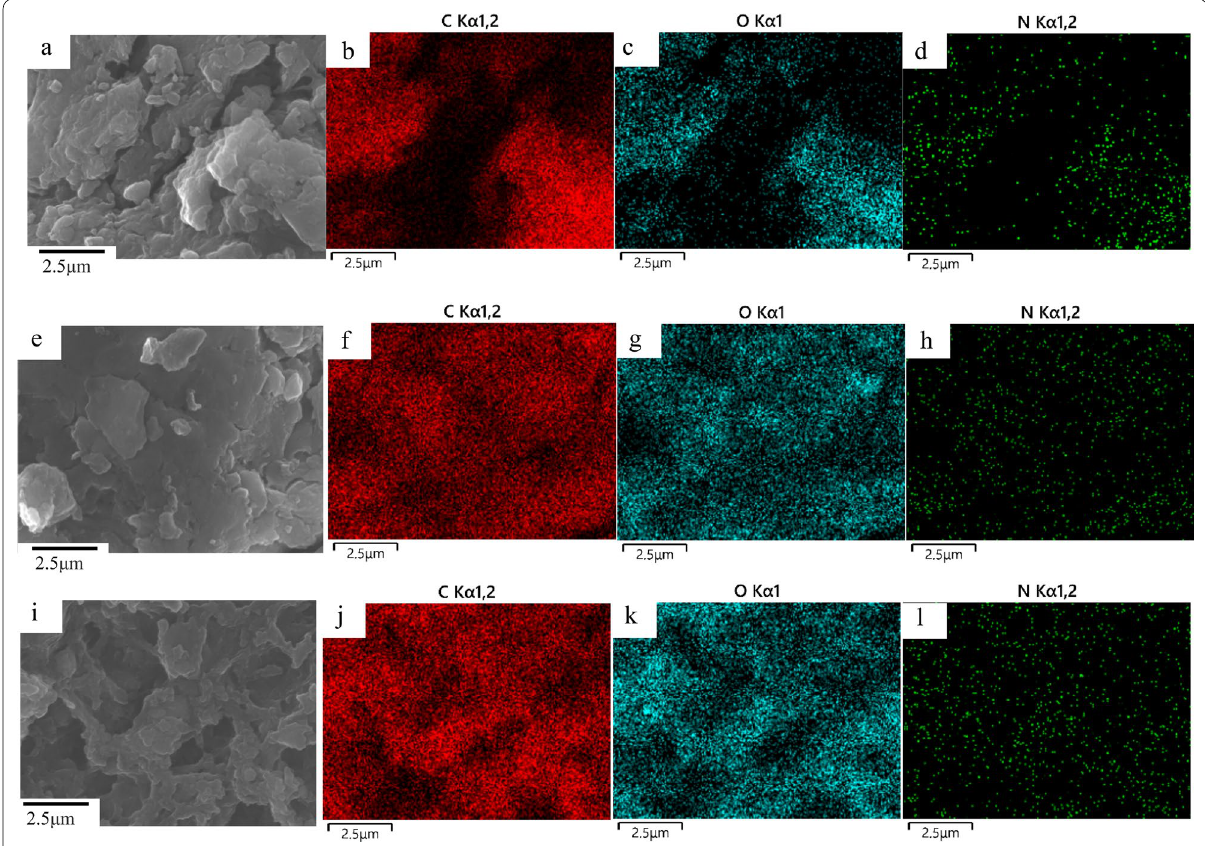
Fig. 2 SEM images and elemental analysis recorded on HBM-400 ( a – d ), HBM-300 ( e – h ) and HBM-200 ( i – l )